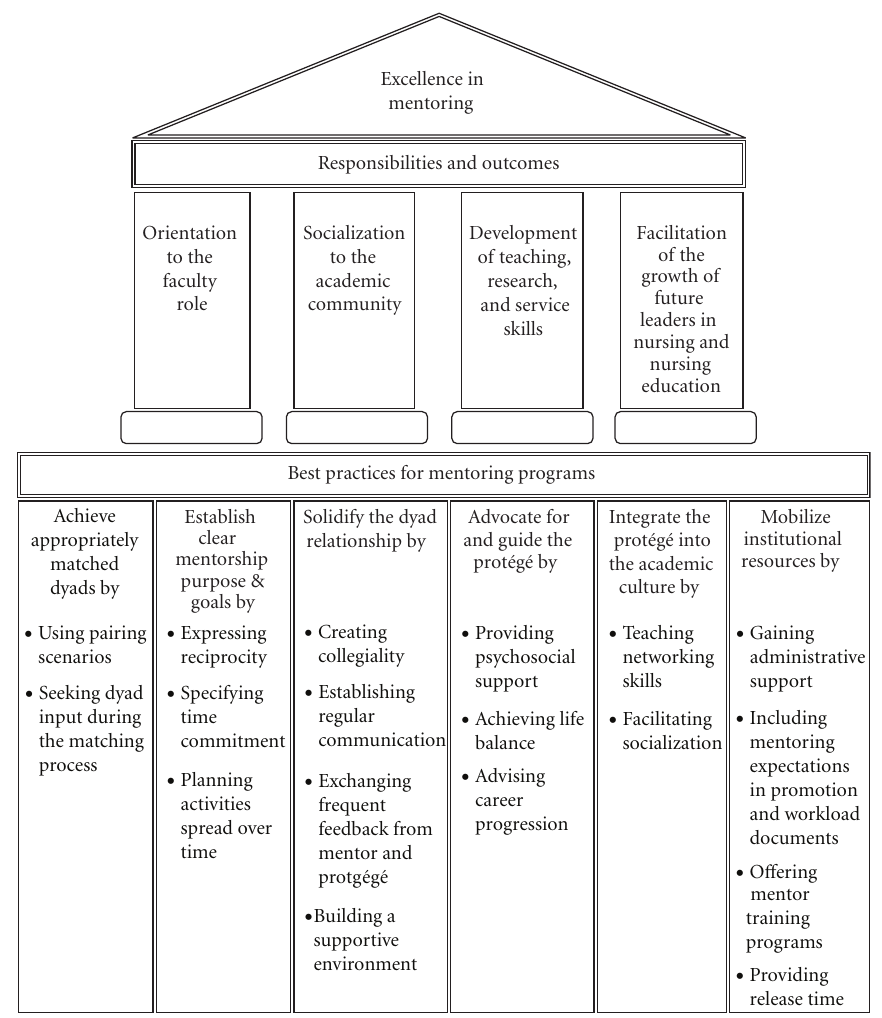
Figure 1: The model: Best Practices in Academic Mentoring: A Model for Excellence. Fourth Cohort, NLN/Johnson & Johnson Faculty Leadership and Mentoring